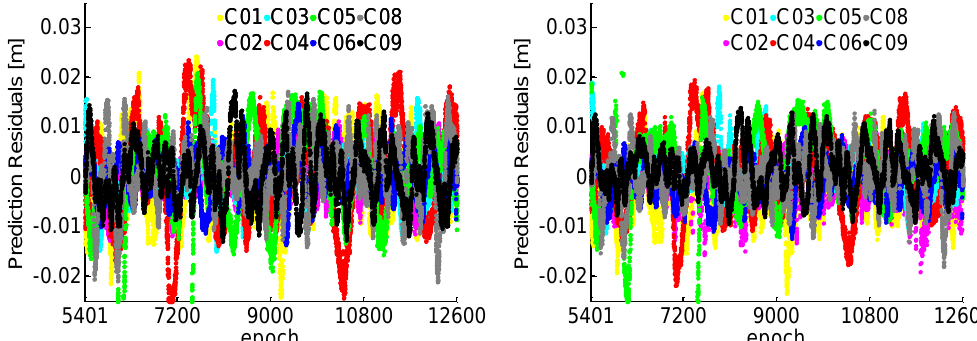
Figure 8. Ionospheric prediction residuals with 180 s intervals. The left panel shows the residuals based on B1 and B2, the right panel based on B1 and B3.